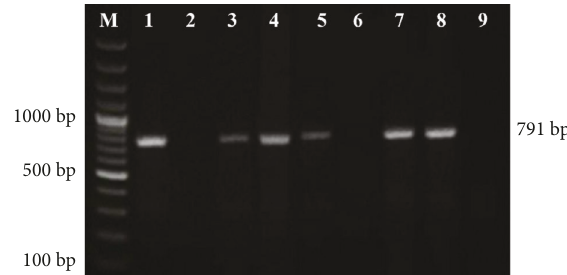
Figure 1: Gel electrophoresis of nested PCR products for am- plification of Toxoplasma gondii GRA6 gene. M: 100bp molecular weight marker. Lane 1: positive control (Toxoplasma RH strain); lane 2: negative control (nuclease-free water); lanes 3, 4, 5, 7, and 8: positive nested PCR samples showed amplification at GRA6 gene- specific bands (791 bp). Lanes 6 and 9: negative